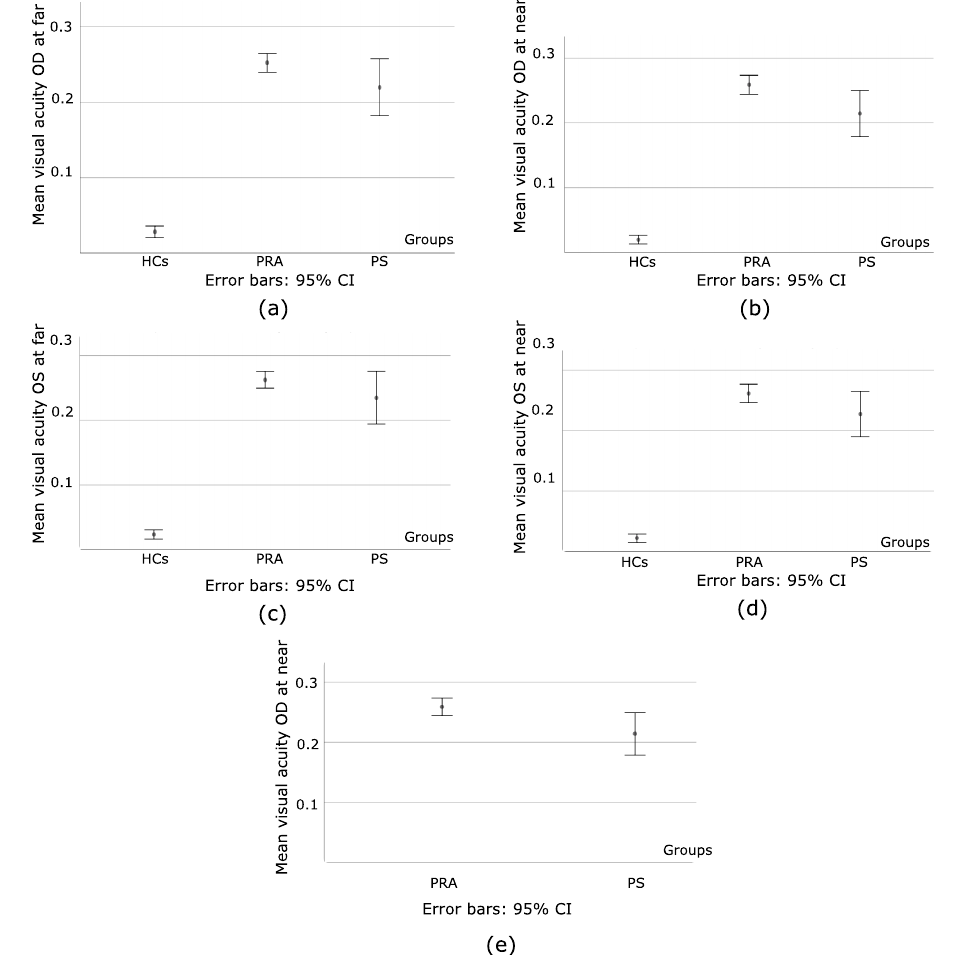
Figure 3. ( a ) Illustrates the mean value of the visual acuity of right eye (OD) at far, and s.d for each group; ( b ) the mean value of the visual acuity of right eye (OD) at near and s.d for each group; ( c ) the mean values of the visual acuity of left eye (OS) at far, and s.d for each group; ( d ) the mean value of the visual acuity of left eye (OS) at near, and s.d for each group; ( e ) the mean value of the visual acuity of right eye (OD) at near and s.d in PRA and PS. What stands out from ( a – e ) is the heterogeneity on the obtained values for PS when compared to HCs and PRA. Using HCs as a reference, the impacts of strabismus and amblyopia on the amount of visual acuity of each eye are made evident and more prominent on PS. Nonetheless, PS has better visual acuity than PRA; greater heterogeneities of the obtained values are observed as a result of the sensory and motor deficits that they present.